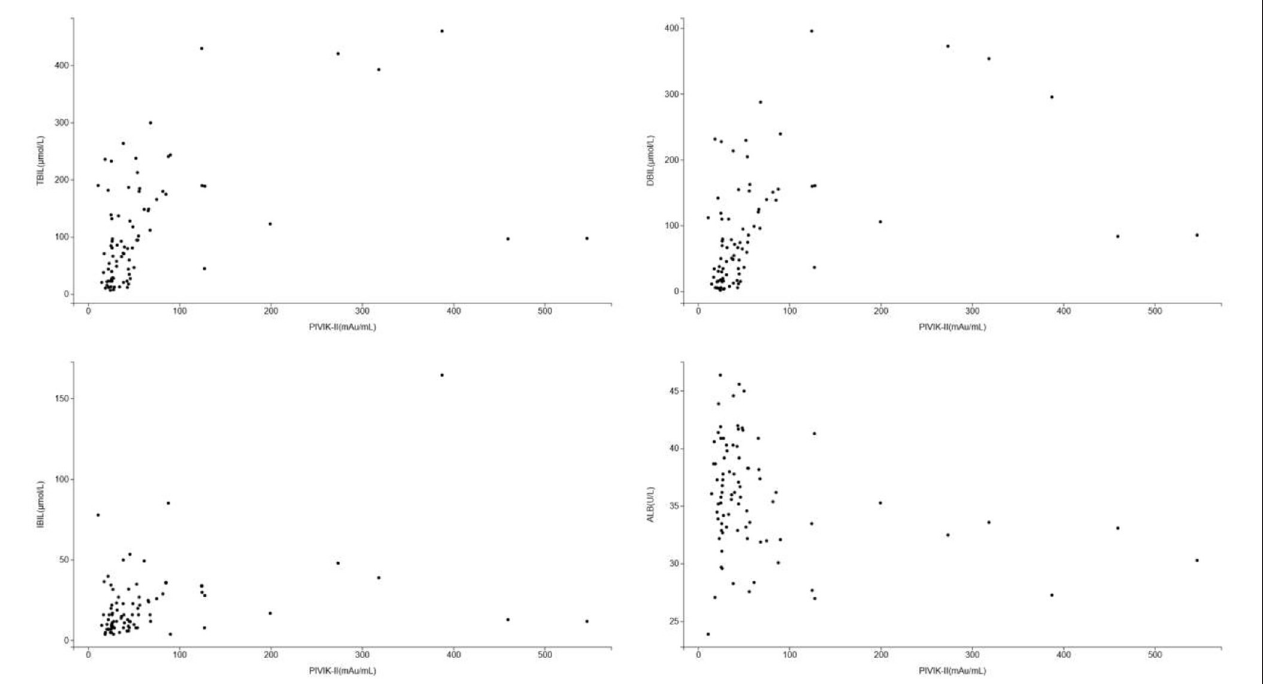
FIGURE 3 | Scatter diagram for the correlation between PIVKA-II and bilirubin and albumin. Each black point represents a sample. PIVKA, protein induced by vitamin K absence or antagonist-II. PIVKA, protein induced by vitamin K absence or antagonist-II.